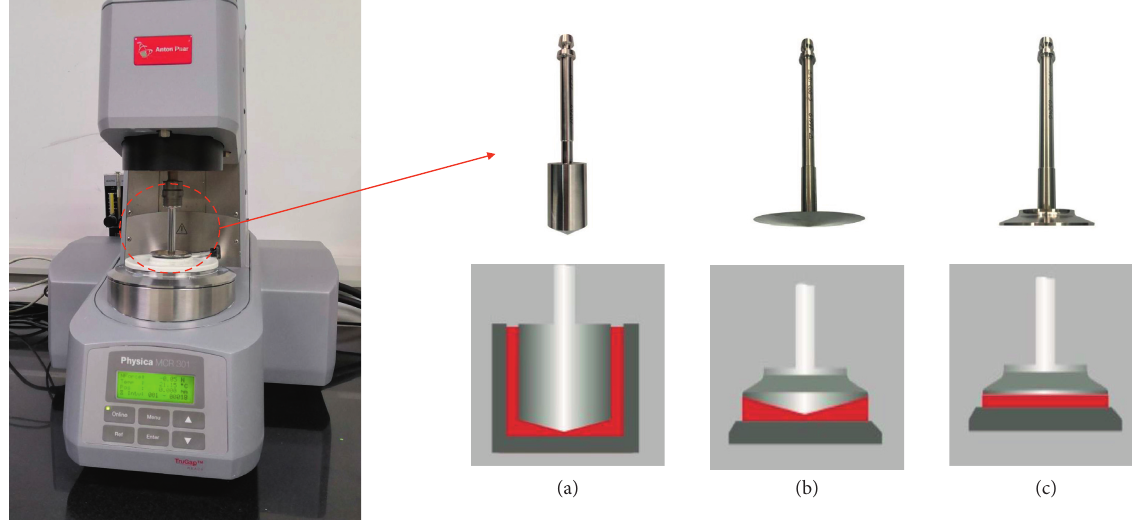
Figure 8: Basic geometries for the rotational rheometer: (a) concentric cylinder; (b) cone and plate; (c) parallel